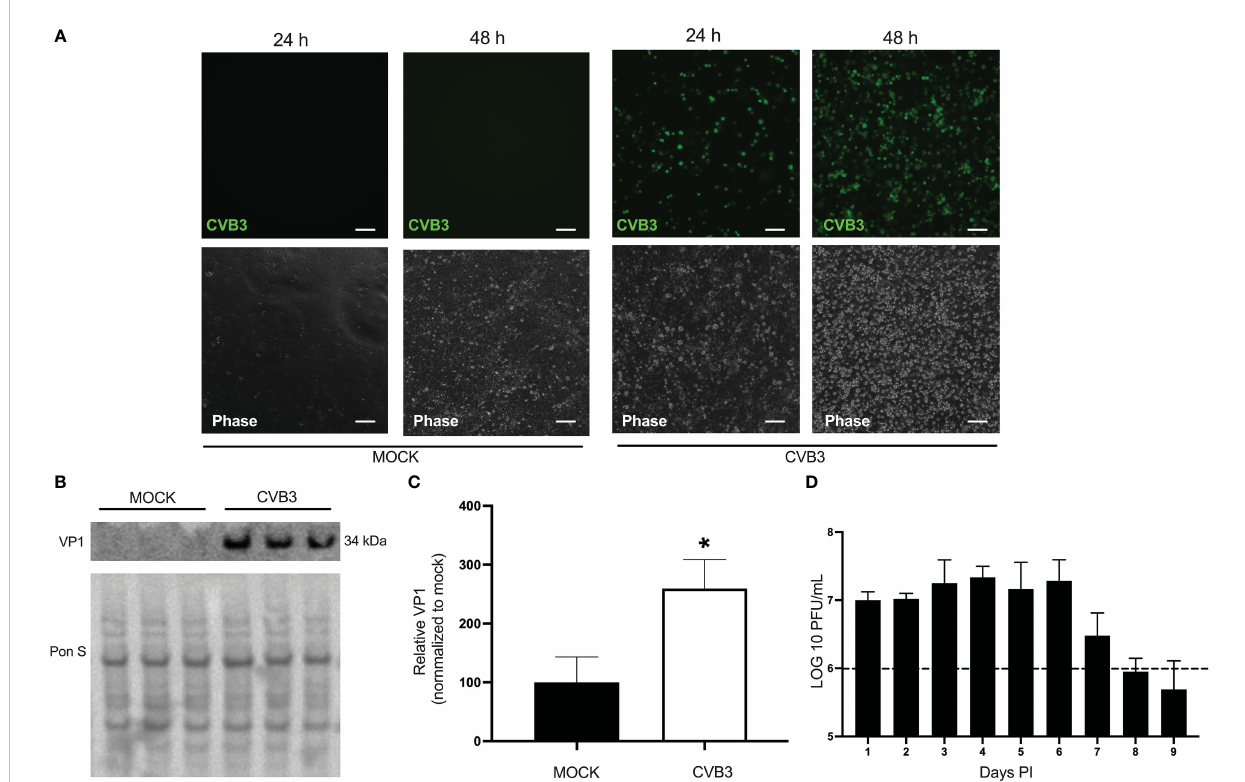
FIGURE 1 Human induced pluripotent stem cell-derived brain-like endothelial cells are susceptible to coxsackievirus B infection. iBECs were infected with eGFP-CVB3 or an equal volume of DMEM at MOI 10 for the durations indicated. (A) Fluorescence microscopy images (top) detecting viral eGFP. Phase contrast images of the same fi eld are shown below. Scale bars= 100 µm. (B) Western blot detecting viral capsid protein VP1 in iBEC lysates that were either infected with eGFP-CVB3 at MOI 10 or mock infected with equivalent volume DMEM for 48 h PI. Ponceau S (Pon S) staining of the membrane is shown below. (C) Densitometric quanti fi cation of (B) . (D) Plaque assay quanti fi cation of infectious viral titers of media from iBECs infected with eGFP-CVB3 from tissue culture plastic coasted plates at MOI 10 (1.12x10 6 PFU/mL) or mock treated with equivalent volume DMEM. Dotted line represents initial inoculum (*p<0.05; student ’ s t -test; n=3. Error bars represent standard